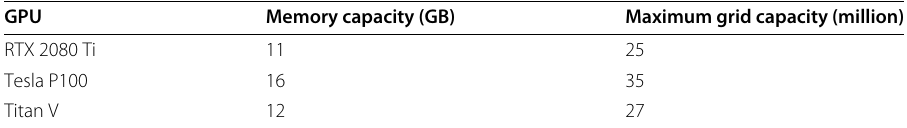
Table 3 Maximum grid capacity of HiResX solver in different GPUs